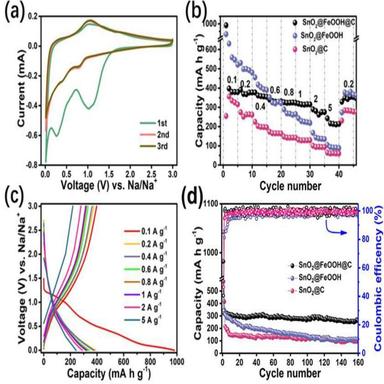
(a) CV curves of SnO2@FeOOH@C composite tested at the scan rate of 0.1 mV s1 , (b) the comparison of rate capability of SnO2@C, SnO2@FeOOH, and SnO2@FeOOH@C at various current densities, (c) the charge/discharge profiles of SnO2@FeOOH@C at various current densities, (d) the comparison of cycling performance of SnO2@C, SnO2@FeOOH, and SnO2@FeOOH@C at the current density of 1 A g1 .